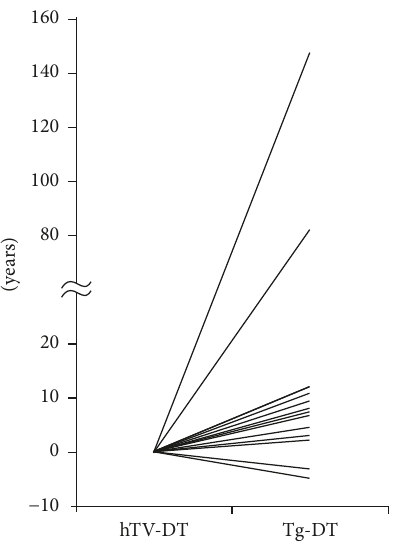
Figure 1: Comparison of hTV-DT and Tg-DT values. hTV-DT: the preoperative hypothetical tumor volume-doubling time; Tg-DT: the postoperative thyroglobulin-doubling time. Two patients showed a decrease in their serum Tg values over time, and thus their Tg-DTs are shown as negative values.